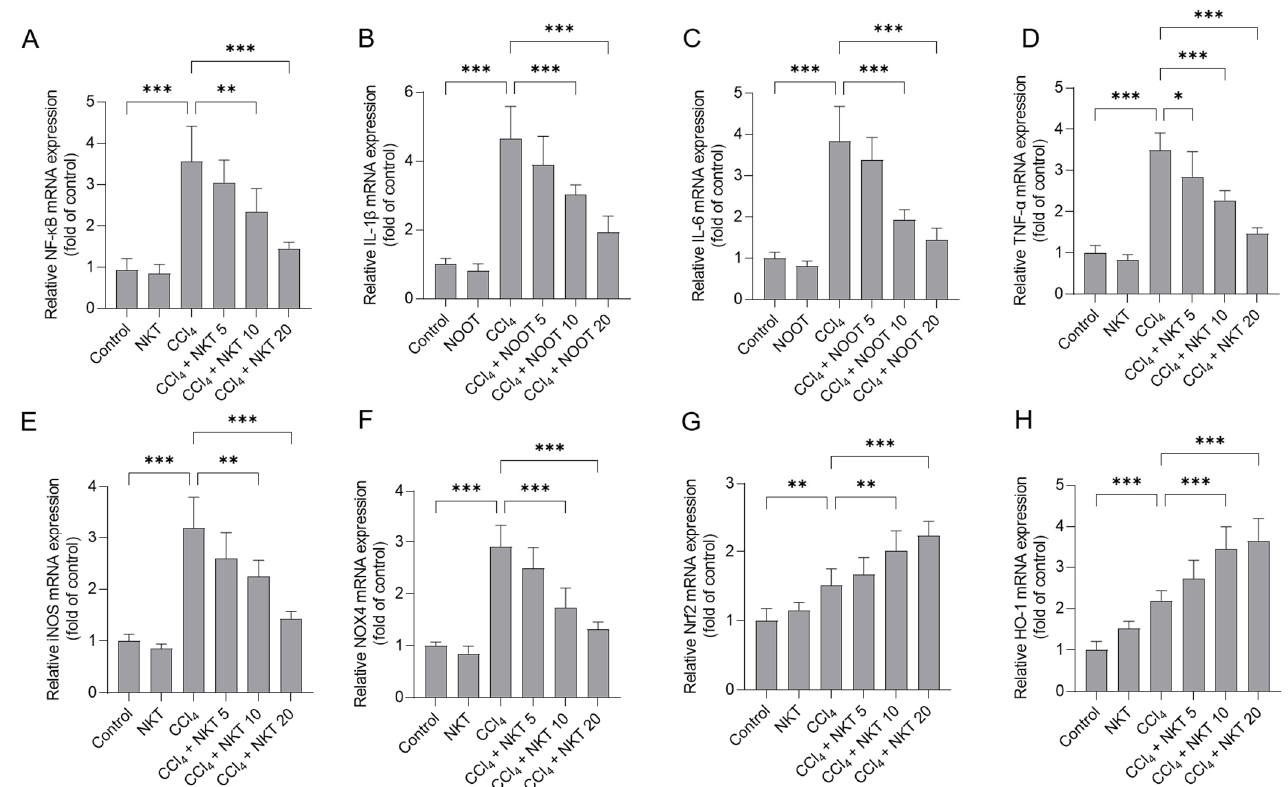
Figure 9. The effects of NKT pre-treatment on the mRNA expressions of different inflammation pathway genes in murine kidney tissues. After 24 h post CCl 4 treatment, the expressions of NF- κ B ( A ), IL-1 β ( B ), IL-6 ( C ), TNF- α ( D ), iNOS ( E ), NOX4 ( F ), Nrf2 ( G ), and HO-1 ( H ) transcript levels in the kidney tissues were determined, respectively. Data are presented as mean ± S.D. ( n = 6 in each group). * p < 0.05, ** p < 0.01, and *** p < 0.001.